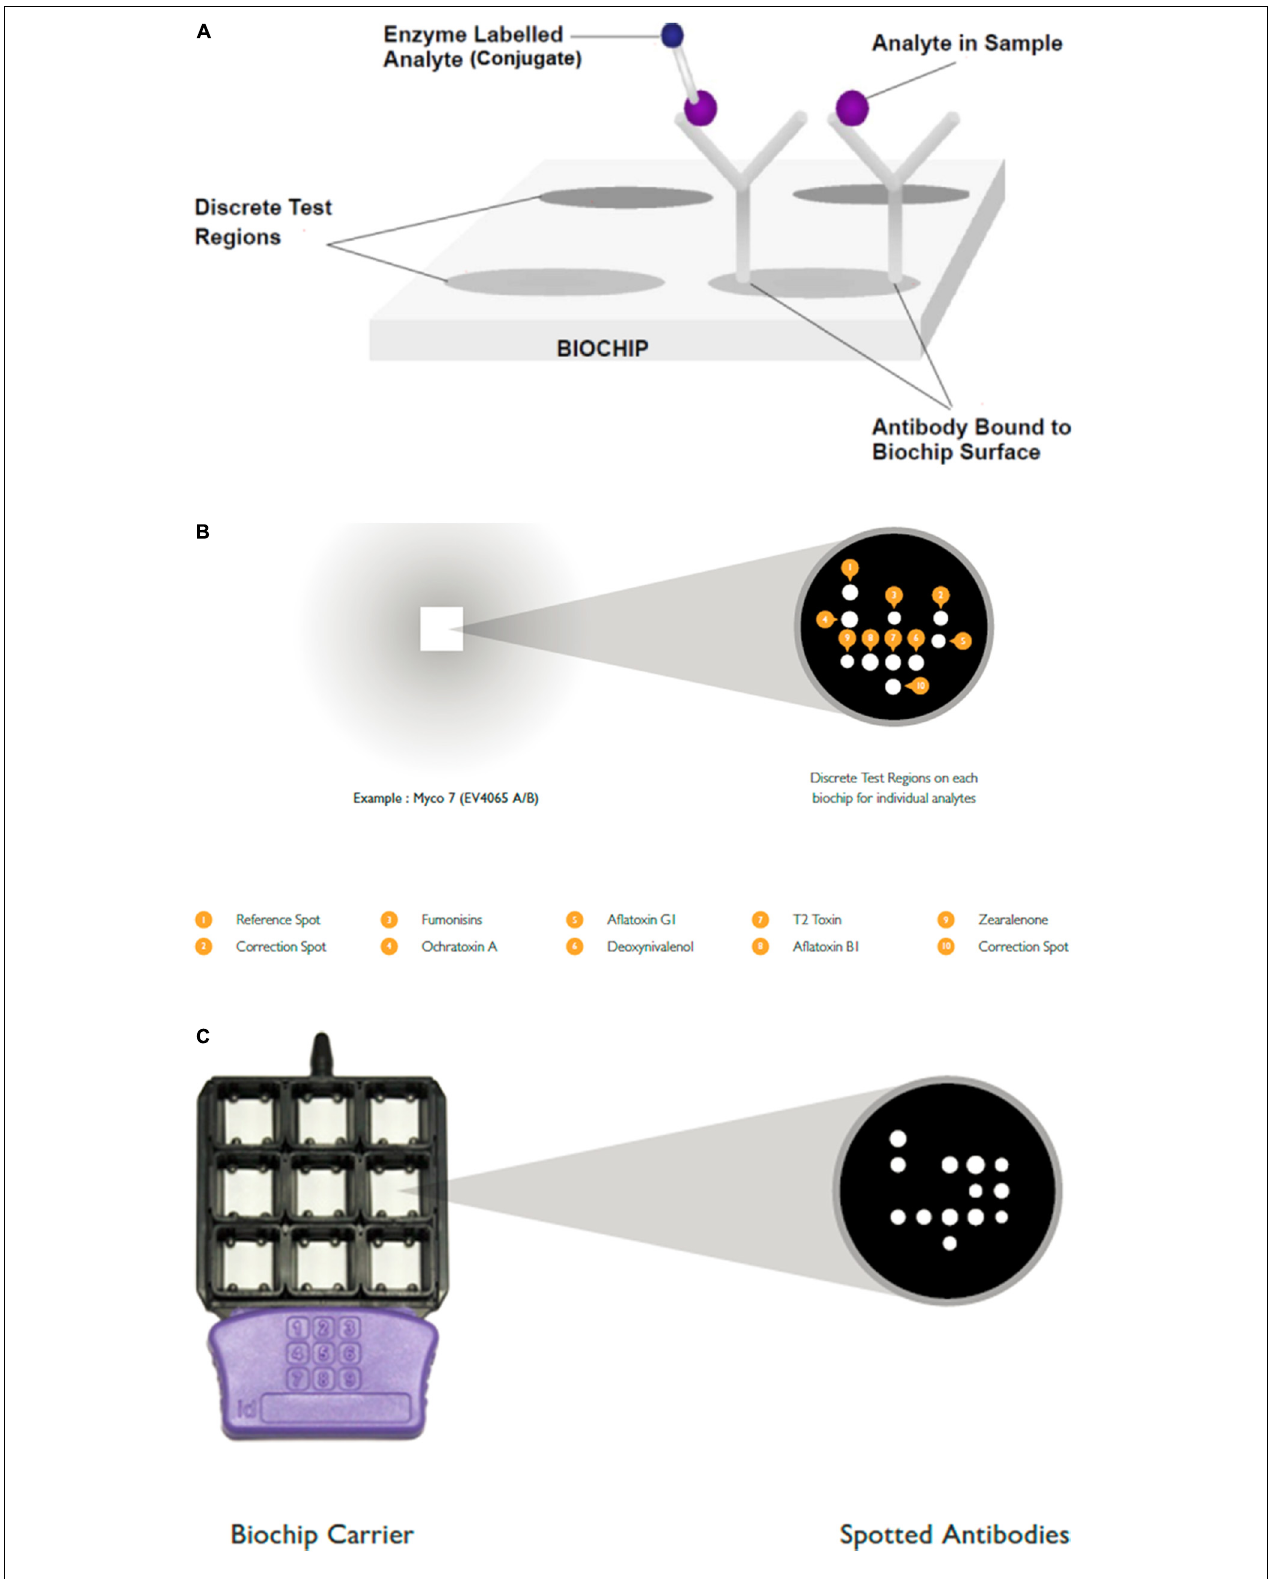
FIGURE 6 | (A–C) shows the principle of Competitive Biochip Assay. Published with the permission of the manufacturer.